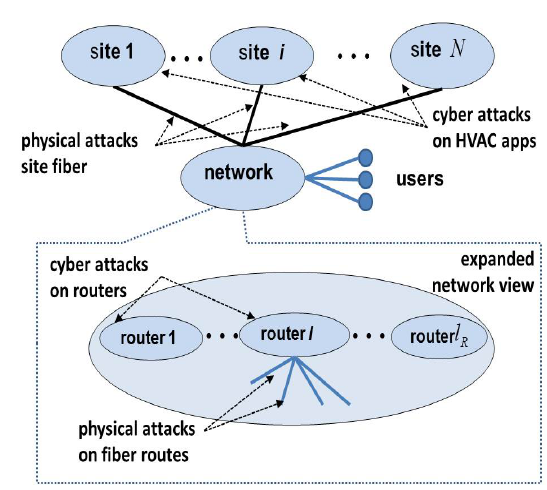
Figure 2. Network of a multi-site cloud server